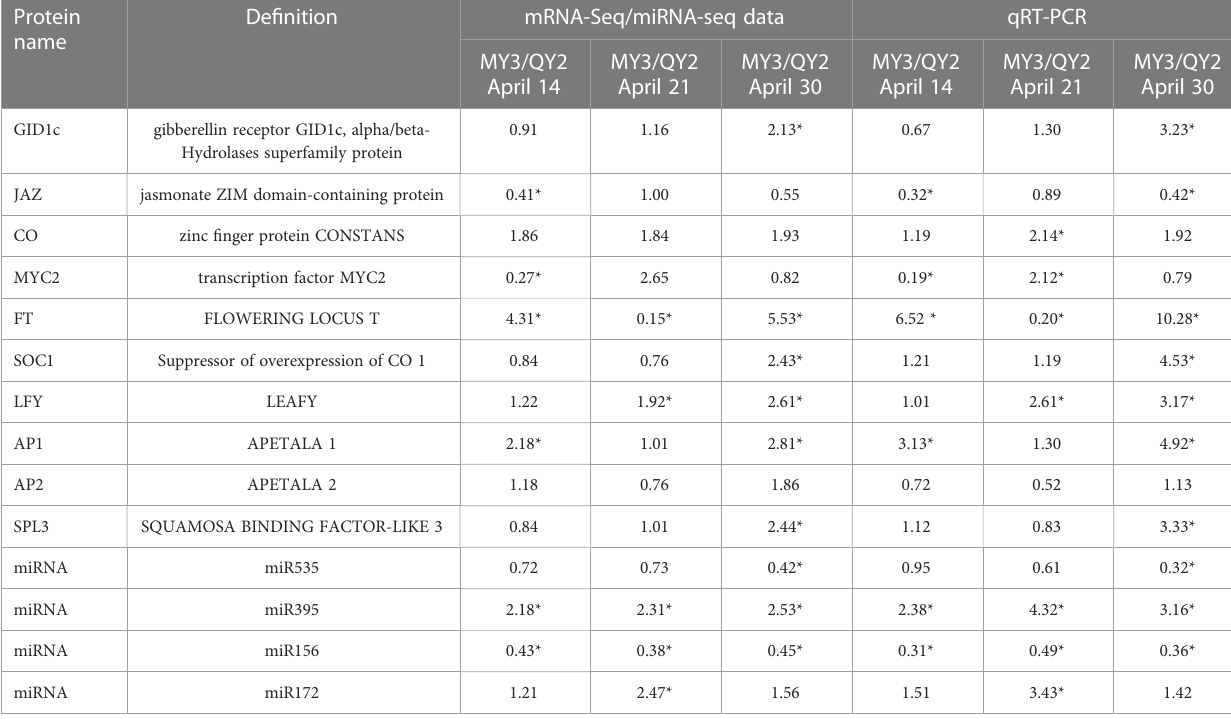
TABLE 2 The comparison of mRNA-Seq/miRNA-seq and qRT-PCR analysis involved in fl ower bud formation in C. oleifera . Protein